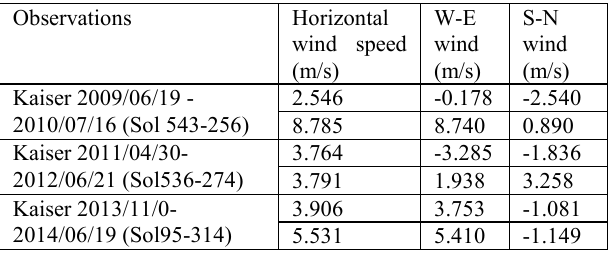
Table 1. Wind vector extracted by Martian General Circulation Model over